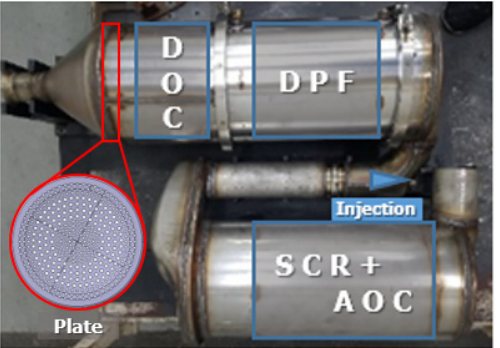
Figure 2. Target aftertreatment device, including a diesel oxidation catalyst (DOC), diesel particulate filter (DPF), and selective catalytic reduction (SCR).